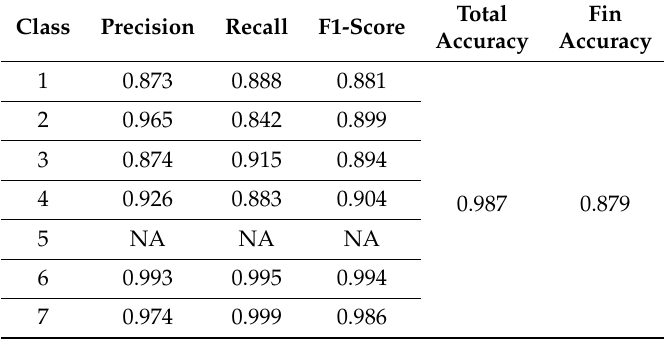
Table 17. Decision tree classifier performance results, given a new seismic airgun signal class (Class